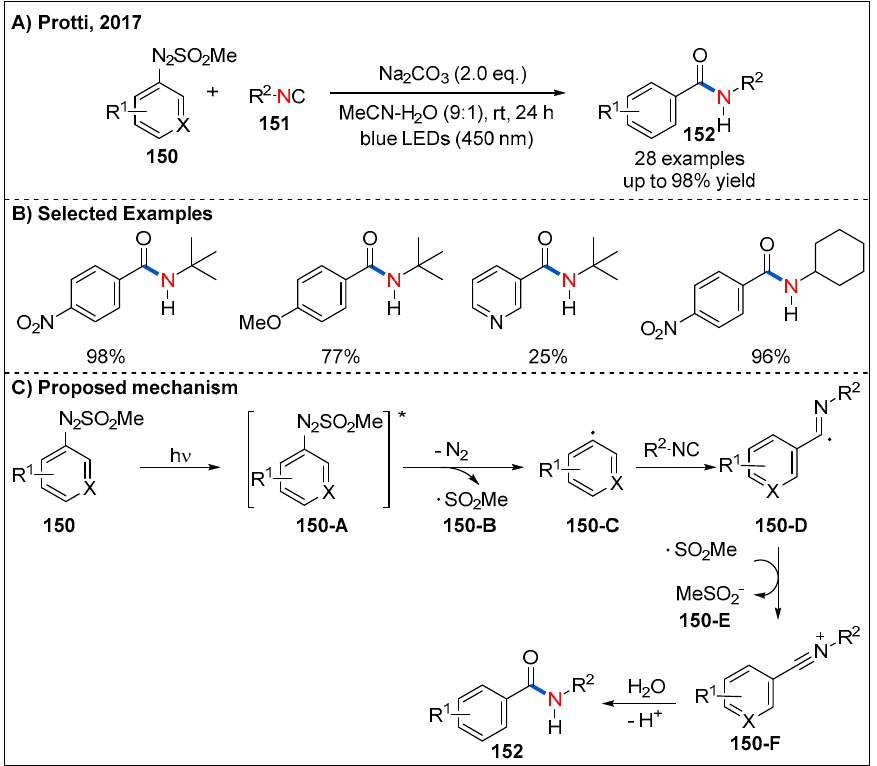
Figure 45. Visible-light-driven metal-free carbamoylation of arylazo sulfones with isocyanides. In 2020, Giustiniano and co-workers developed a visible-light-driven photoredox- catalyzed method for the formation of secondary amides from electron-poor organic bro- mides and isocyanides (Figure 46) [104]. In this process, treatment of organic bromides with isocyanides in the presence of fac -Ir(ppy) 3 , Na 2 CO 3 and DABCO under irradiation of blue LED gave rise to amide products in good to high yields. The addition of a sacrificial electron donor, diazabicyclo[2.2.2]octane (DABCO), is key to improving the yield. In addition to working as a common base, it was reasoned that DABCO can also act as a sacrificial electron donor to facilitate regeneration of the Ir(III) photocatalyst. Interestingly, aryl bromides with an electron-withdrawing group at the phenyl ring are also compatible with reaction though with decreased yields of amide